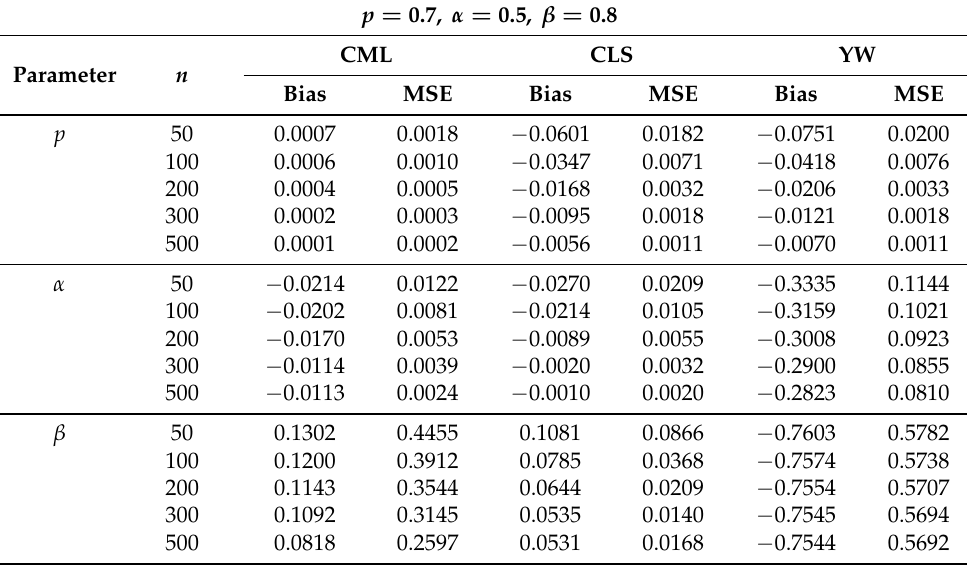
Table 7. Simulation for the INAR(1)PEE model for p = 0.7, α = 0.5, β = 0.8. p = 0.7, α = 0.5, β =